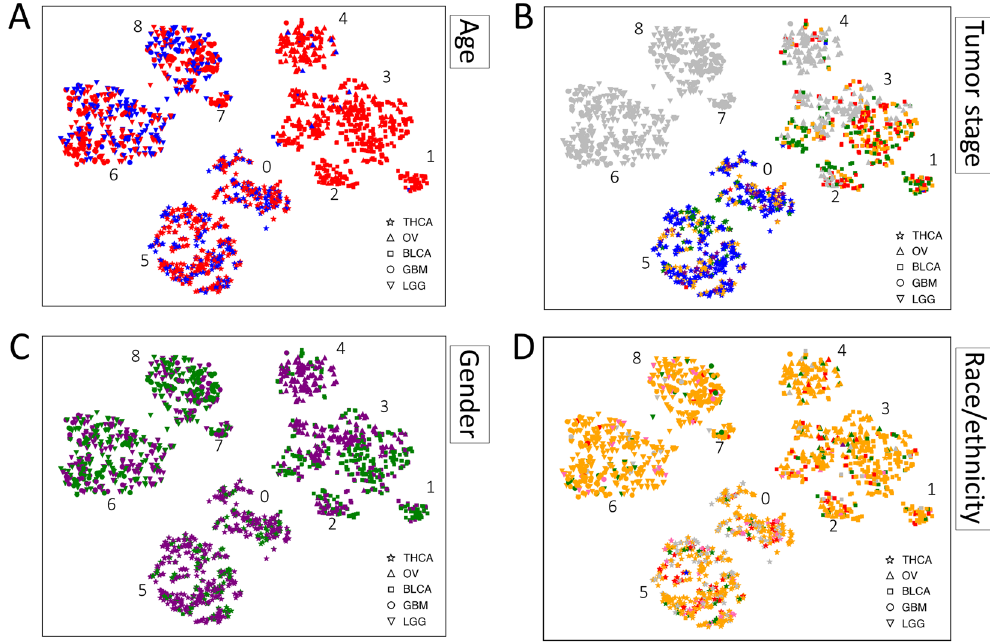
Figure 3. t-SNE Embeddings of 48 Transcripts Color-coded for Patient Attributes. ( A ) Age: red = “age at or above 40”, blue = “age below 40”; ( B ) Race/ethnicity: blue = “American Indian or Alaska native”, red = “Asian”, green = “Black or African American”, purple = “native Hawaiian or Pacific islander”, pink = “Hispanic or Latino”, yellow = “white”; ( C ) Gender: green = “male”, purple = “female”; ( D ) Tumor stage: blue = “stage I”, green = “stage II”, yellow = “stage III”, red = “stage IV”, purple = “stage IV-A/B/C”. Gray in all cases indicates missing data. Note the embedding of the samples used here is different than Fig. 1B but the cluster identities are identical.